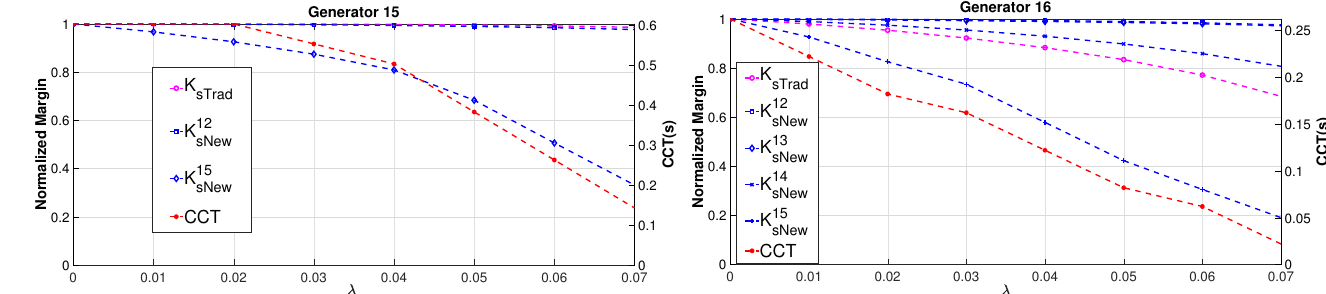
Figure 4. Transient stability analysis of critical generators in New England 68-bus test